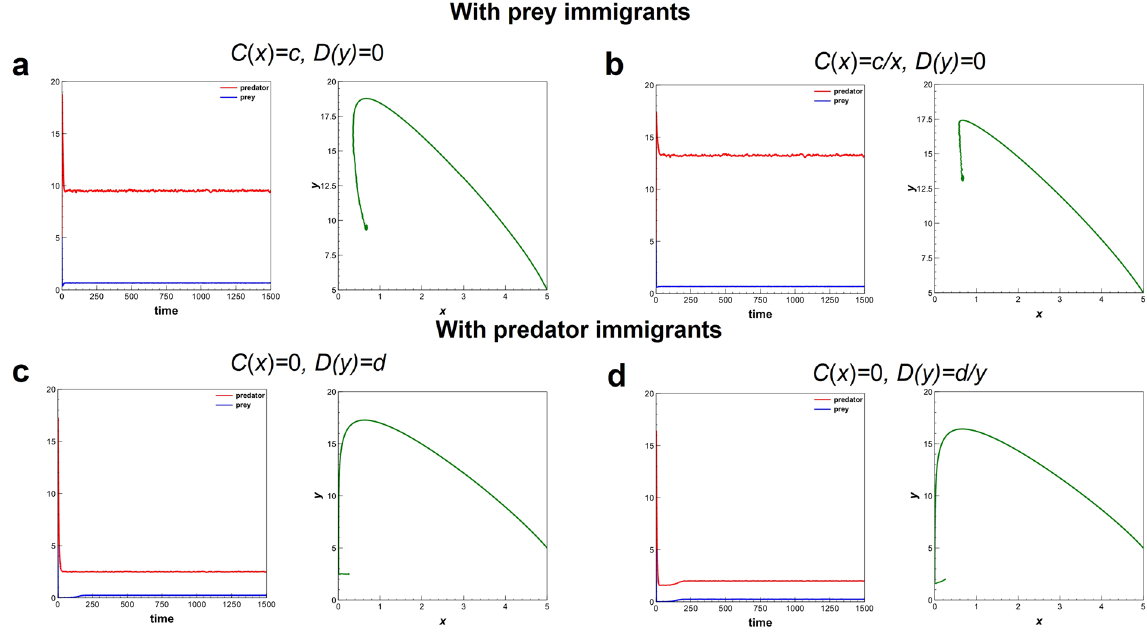
Figure 2. Modified LV model with random number of immigration at regular interval. Four cases of the modified LV system (1) with random number of immigration. Parameter values: Initial x = 5, Initial y = 5, r = 0.2, a = 0.1, b = 0.3, m = 0.2, c = random(0.001, 1), d = random(0.001, 1). Results are shown for 1,500 steps, with an average of 15 runs. Random ( i , j ) means uniform random number between i and j .